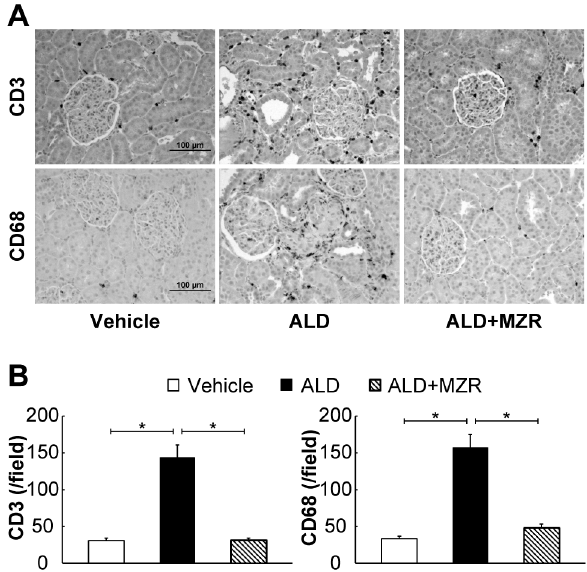
Figure 1. Mizoribine suppresses aldosterone-induced renal inflammation. Aldosterone (ALD) induced considerable T lymphocyte and macrophage infiltration in the rat kidneys, whereas the infiltration was suppressed by mizoribine (MZR). (A) Representative photomicro- graphs of renal T lymphocyte infiltration (CD3 staining) and macro- phage infiltration (CD68 staining). (B) Graphs show the quantification of CD3-positive and CD68-positive cells. Values are presented as mean 6 SEM. * P ,